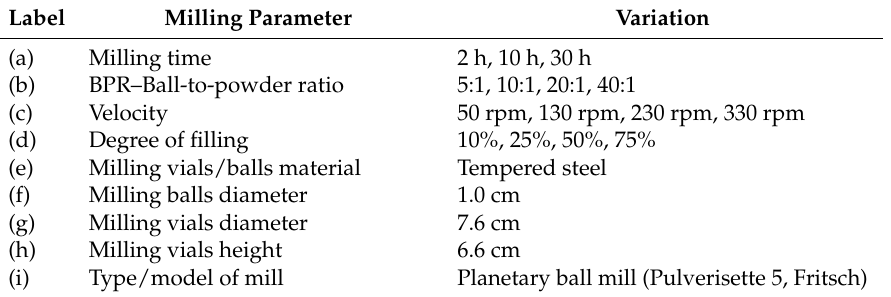
Table 1. General summary of the milling parameters. Italic font indicates the variations examined here.